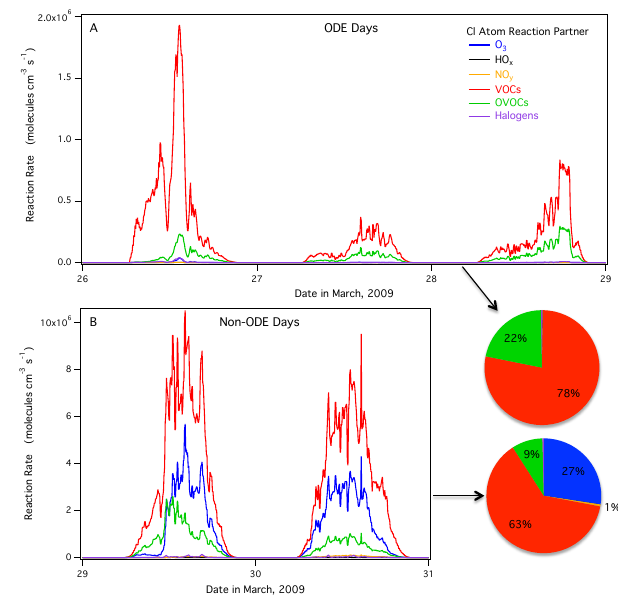
Figure 8. Rates of reaction for the most important Cl atom reaction partners during ODE days ( a ; O 3 >5ppbv) and non-ODE days (b) . The corresponding pie charts represent the fractional importance of each sink, calculated as median values across the days shown. HO x is defined as the sum of OH and HO 2 , NO y is the sum of all nitro- gen oxide compounds, VOCs include all non-functionalized alka- nes, alkenes, and acetylene, OVOCs include all non-radical organic compounds with an oxygen (carbonyls, ketones, carboxylic acids), and halogens include all inorganic halogenated species.